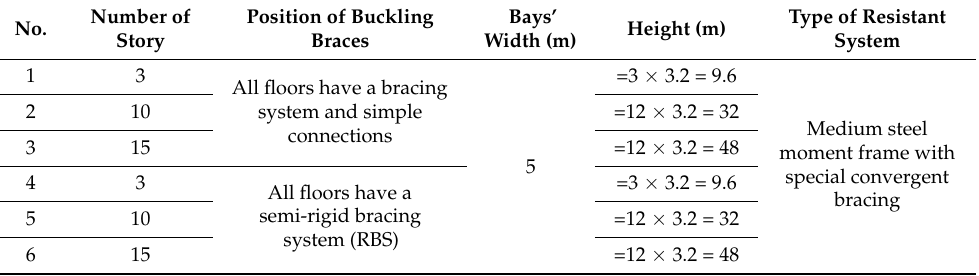
Table 1. Details of the structures considered in this research.